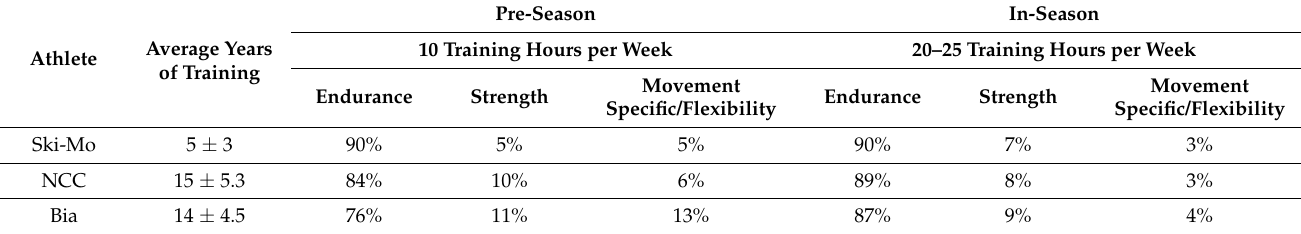
Table 1. Baseline training schedule in winter sport